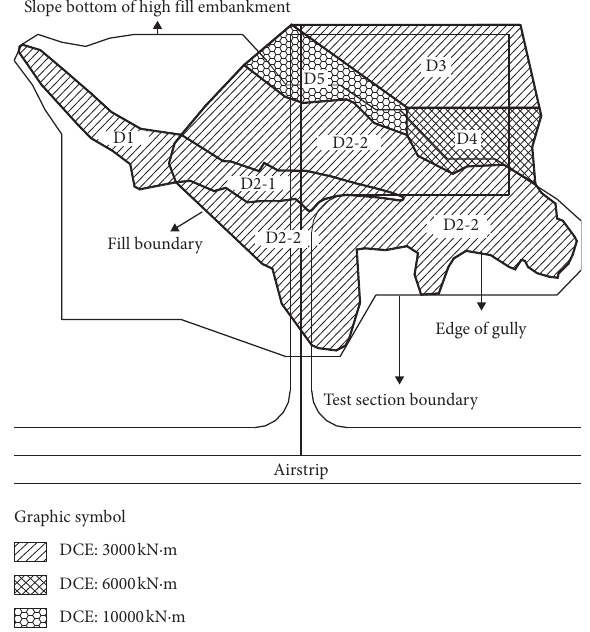
Figure 8: Foundation soil treatment with DC